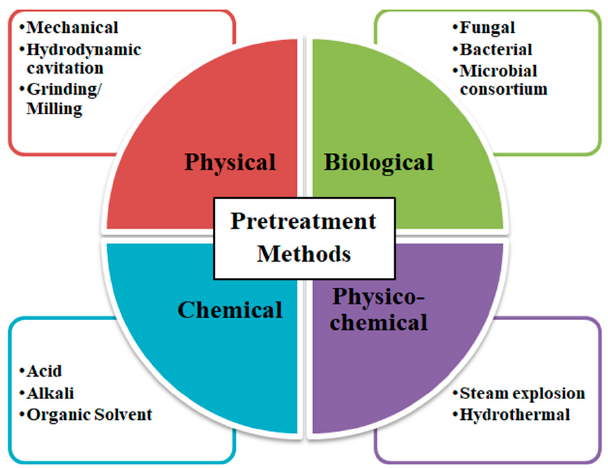
Figure 1. Methods of the pretreatment of lignocellulosic biomass.